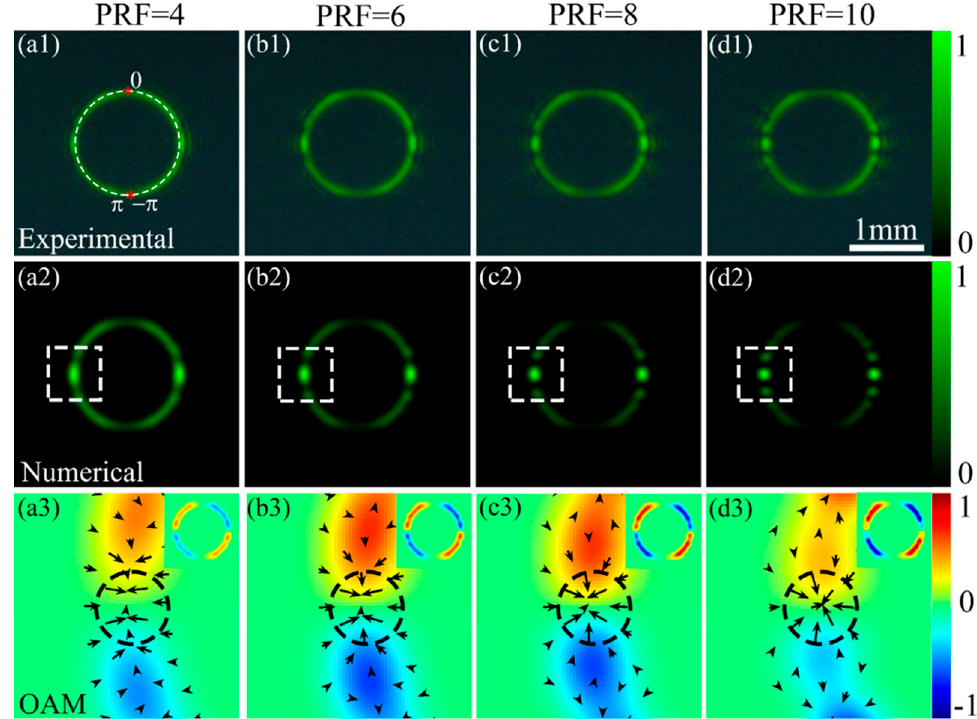
Figure 4. Distributions of the intensity and OAM density of the CSOVs with the PRF = 4, 6, 8, 10, respectively. ( a1 – d1 ) are experimental intensity, ( a2 – d2 ) are numerical simulation intensity, and ( a3 – d3 ) are OAM density distribution.